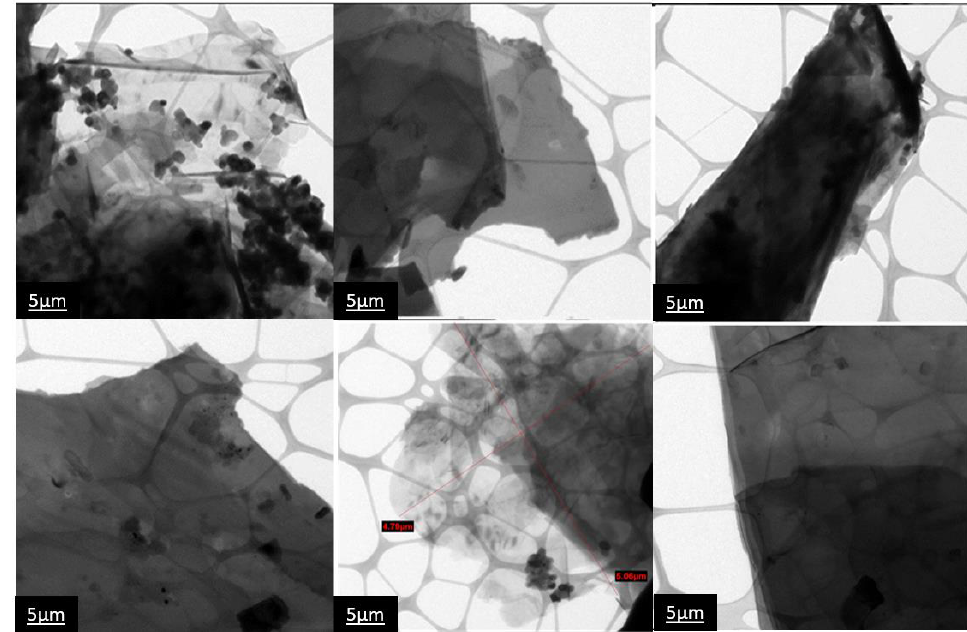
Figure 6. TEM PANI/g-POCN micrographs.